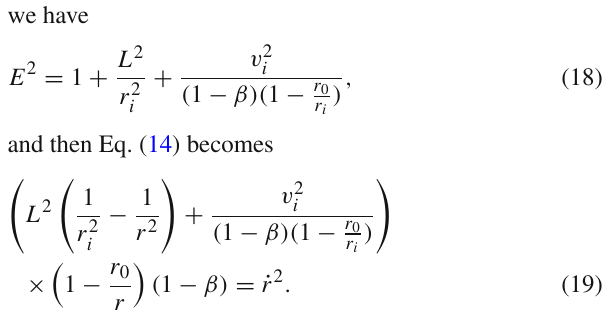
Fig. 4 The behavior of the radial velocity for the geodesics G 1 (dotted line) and G 2 (solid line) with a same value of L is shown in a . The throat is located at r 0 = 1. The velocities for a given common value ( r ) | > | v ( r ) | . We see that both r i > r 0 satisfy the condition | v i i G 1 G 2 geodesics are confined to one side of the wormhole. The reversal radius are different: for G 1 the turning point is located at the wormhole throat, while for G 2 the turning point is located at a radius greater than r 0 . (cid:7) E 2 − 1 − L 2 is In b , the qualitative behavior for the branch ˙ l = r ( l ) 2 − shown for different values of E , L and r 0 . For dashed curves L 2 E 2 − 1 r 0 L √ ≥ 0, then reversal points do exist, while for the solid E 2 − 1